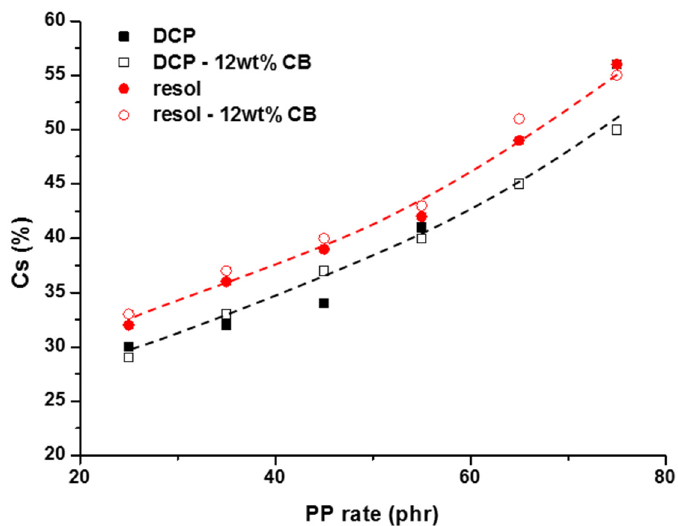
Figure 6. Variation of the compression set (Table 2) versus the PP concentration in the TPV formulation. Amount of chemical reagent in the formulations: 4 phr (DCP) and 7 phr (Resol). Table 2. Values of compression set for TPV based on a decreasing concentration of the PP phase. Amount of crosslinker in the formulations: 4 phr (DCP) and 7 phr (Resol). Amount of CB: 12 wt